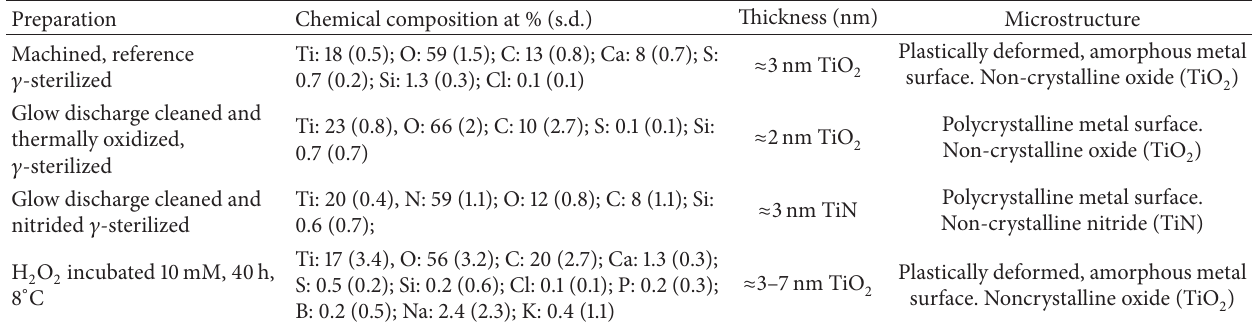
Table 1: Results from AES investigation of screw shaped Ti implant surface layers.